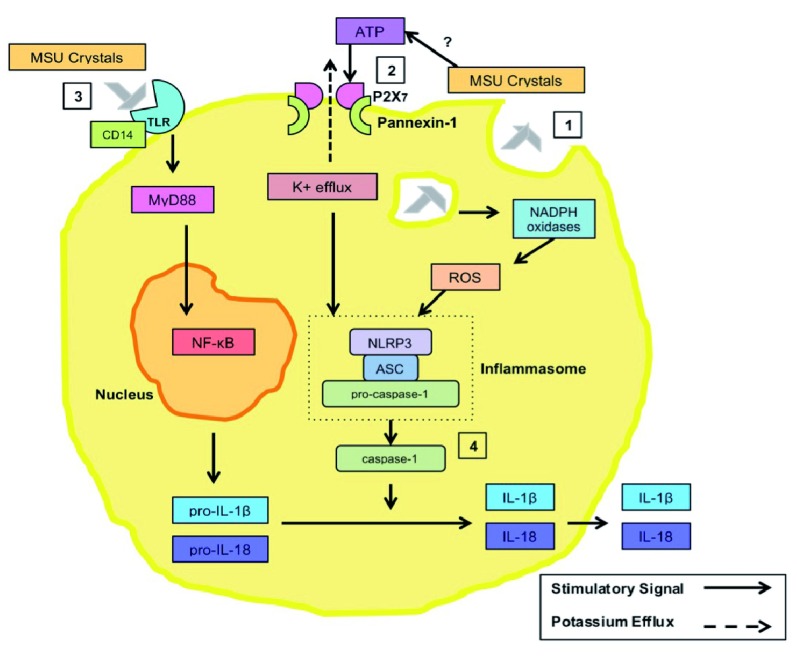
Activation of the NLRP3 inflammasome and the production IL-1β.(
1) Monosodium urate (MSU) crystal phagocytosis stimulates the NADPH (nicotinamide adenine dinucleotide phosphate) oxidase to generate reactive oxygen species that in turn can activate the NLRP3 (NOD-like receptor protein 3) inflammasome. (
2) MSU crystals may also stimulate the secretion of ATP, which can engage and activate the purinergic receptor P2X7, resulting in recruitment of pannexin-1 channels. The resultant rapid efflux of potassium, and the lowering of intracellular potassium, can also trigger inflammasome activation. (
3) Concurrently, MSU crystal interactions with Toll-like receptors (TLRs) on the cell surface stimulate the production of pro-IL-1β via MyD88- and NF-κB-dependent pro-IL-1β gene transcription. (
4) Once stimulated, the NLRP3 inflammasome’s enzymatic effector caspase-1 cleaves the pro-IL-1β to biologically active IL-1β. IL-1β is then secreted from the cell into the extra-cellular fluid of the site of inflammation. ASC, apoptosis-associated speck-like protein containing a caspase recruitment domain; IL-1β, interleukin-1 beta; NF-κB, nuclear factor-kappa B; NLRP3, NOD-like receptor protein 3; ROS, reactive oxygen species; TLR, Toll-like receptor.